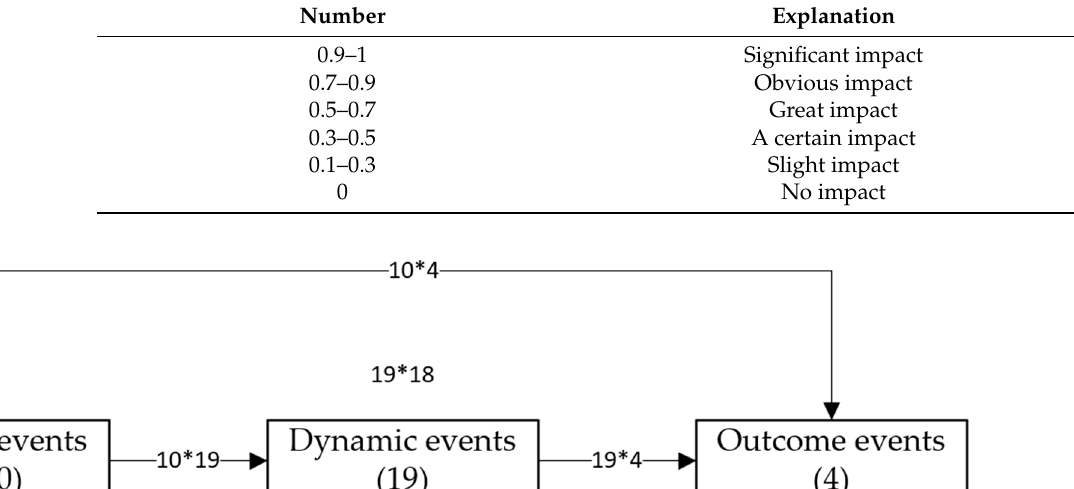
Table 1. Score table.